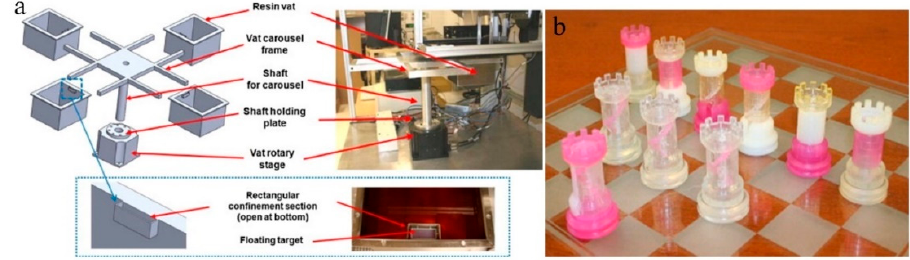
Figure 27. ( a ) Multi-vat carousel assembly employed in SLA 3D printing and ( b ) multi-material 3D printed articles using SLA. Reproduced with permission from [57]. Copyright © 2022 Elsevier.